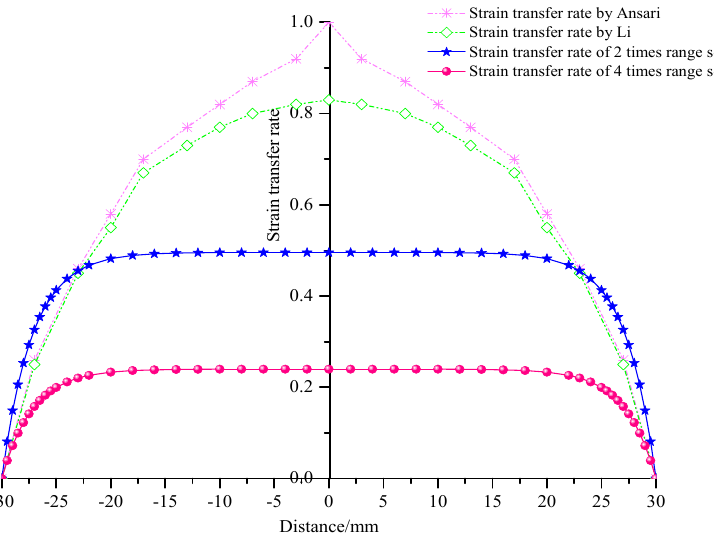
Figure 5. The strain distribution of wide-range FBG sensor.